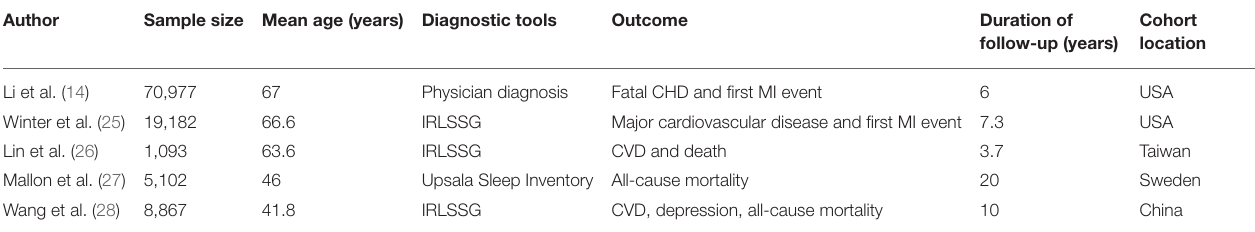
TABLE 2 | General characteristics of studies on the Restless Legs Syndrome